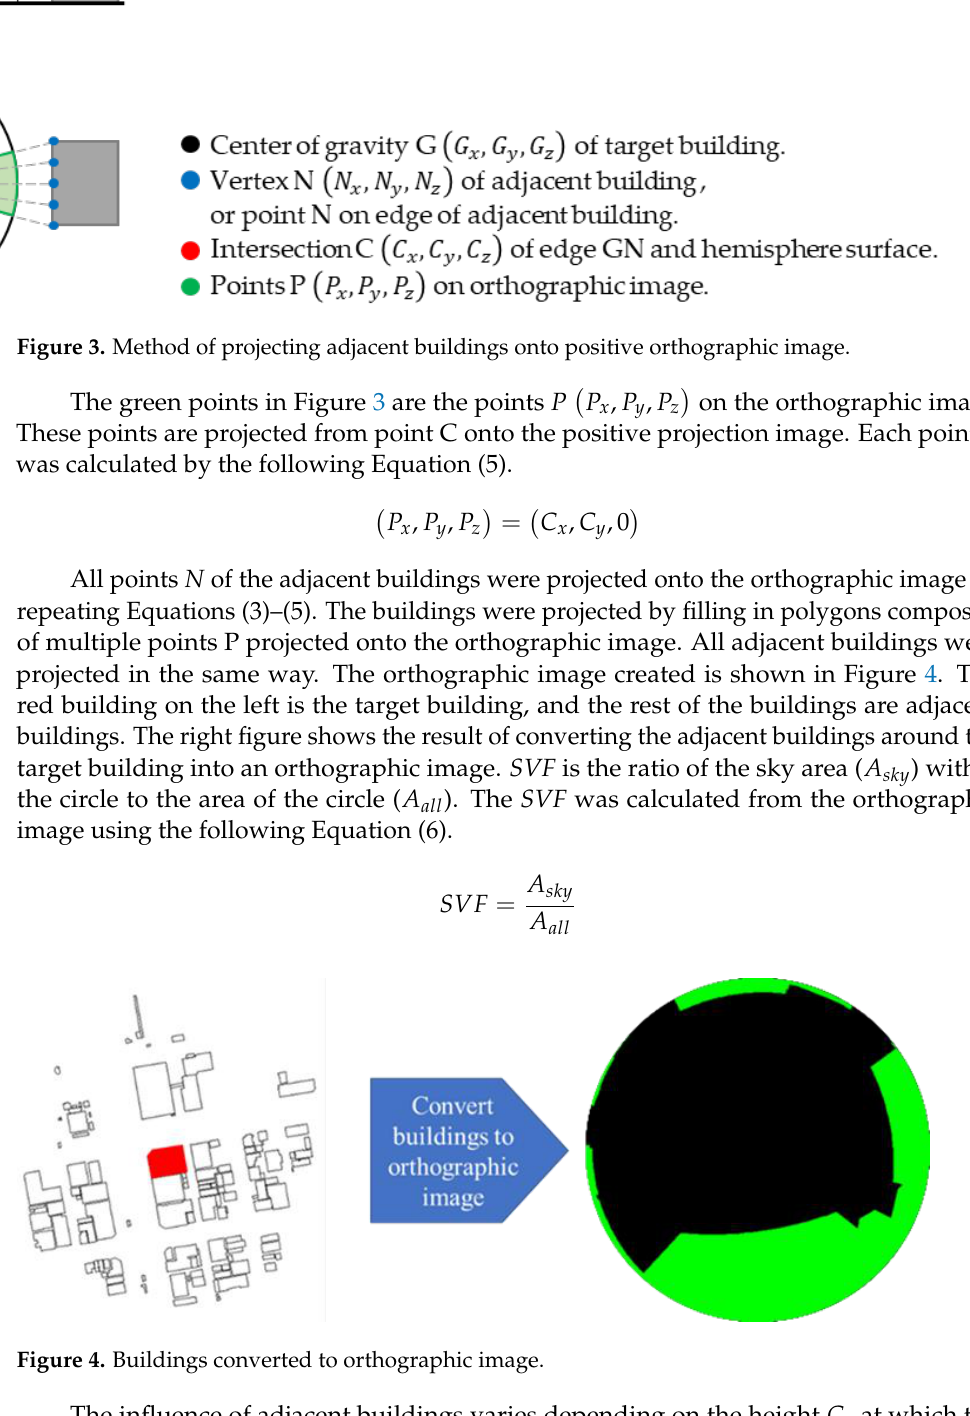
Figure 4. Buildings converted to orthographic image.